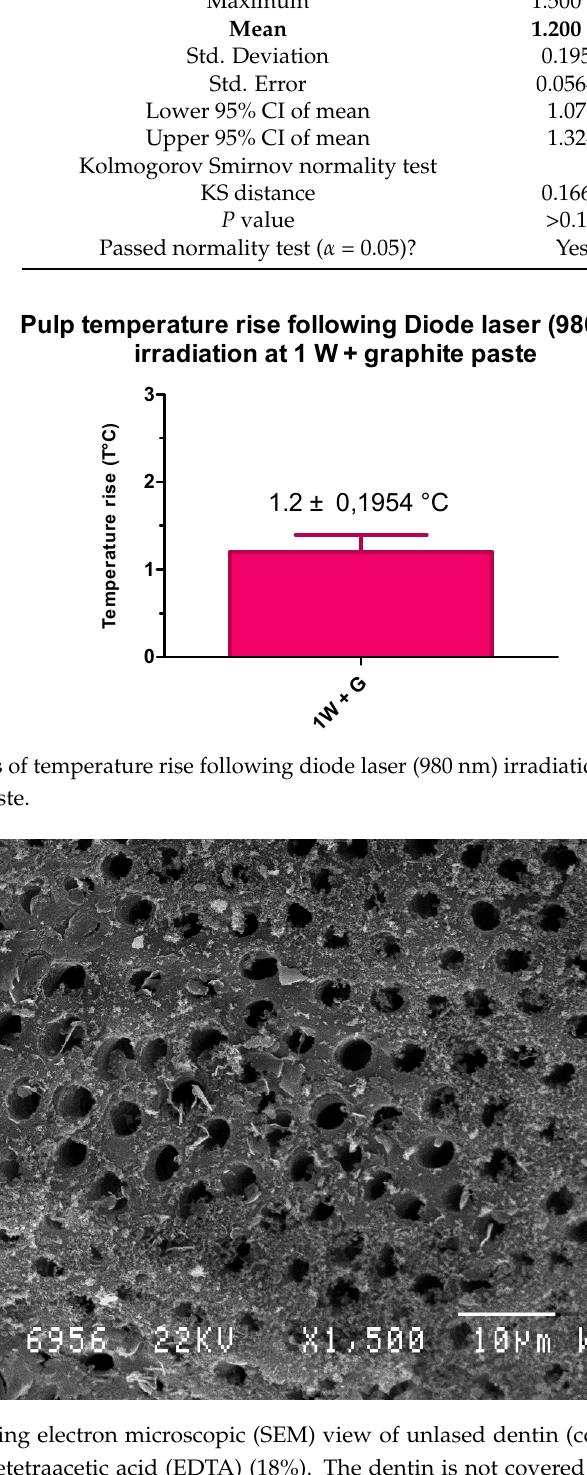
Figure 4. Scanning electron microscopic (SEM) views of treated dentin by diode laser (980 nm) at 1 W. A narrowing of dentinal tubules can be noted. Only a few tubules are completely obliterated. Graphite particles still exist on the dentinal surface (not disintegrated by the laser beam). Magnification: 1500×. 4. Discussion According to the results, the null hypothesis was rejected. Dentinal hypersensitivity’s incidence has been increasing due to many factors, and to this day no standard treatment has been available [30,31]. Conventional treatment was based on the use of desensitizing agents fixed on the dentinal surface, but the limitation of this treatment is that these agents do not last; therefore, the effectiveness is just temporary [32]. In this in vivo study, the decrease of DH was statistically significant and with long-term success. The effectiveness of this treatment can be explained by Brannstorm’s hydrodynamic [33] theory. The obliteration of dentinal tubules by laser beam-generated heat inhibits